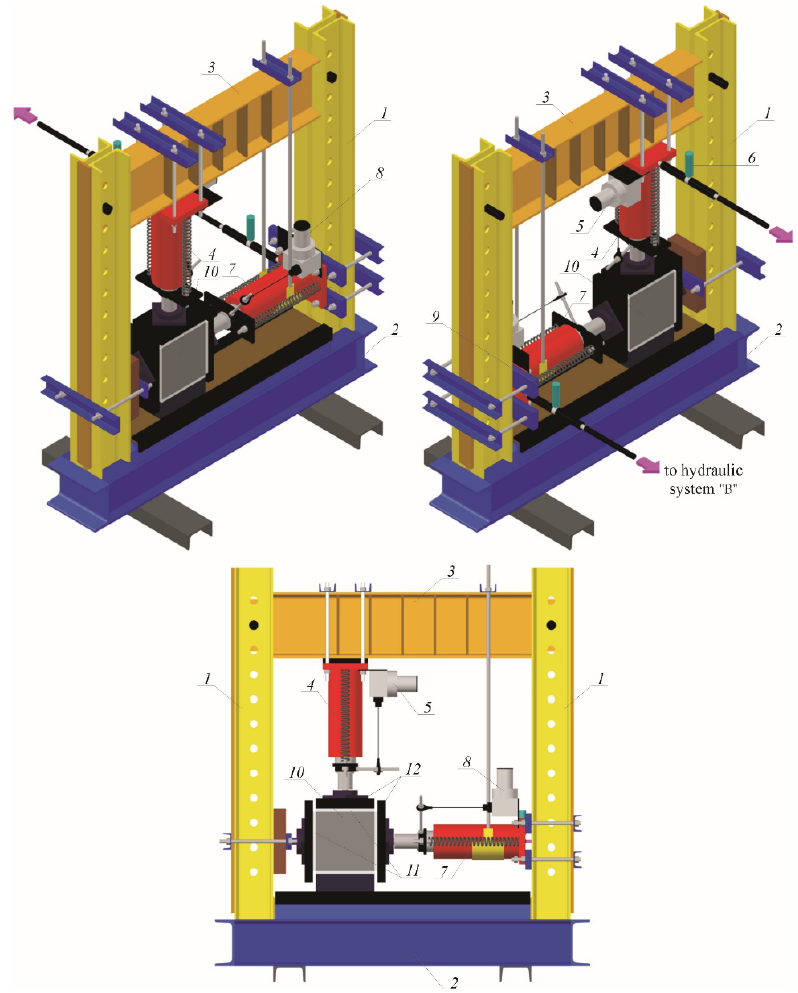
Figure 2. Test stand for measuring the acoustoelastic effect under the biaxial stress state (described in the text).